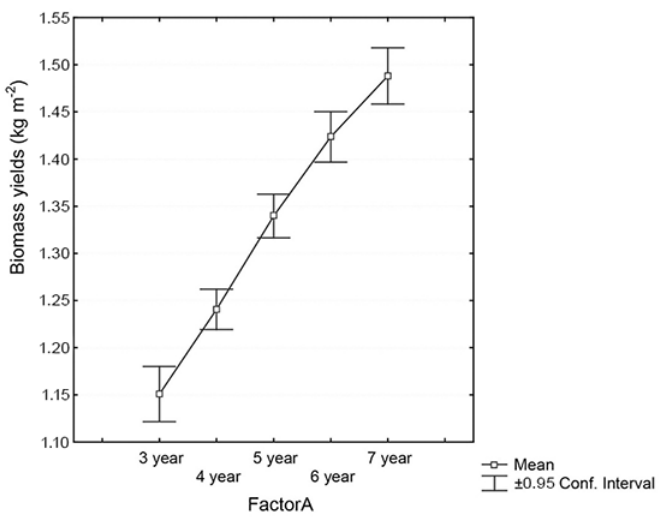
Fig. 5 Biomass yields for the years of switchgrass cultivation (Factor A),